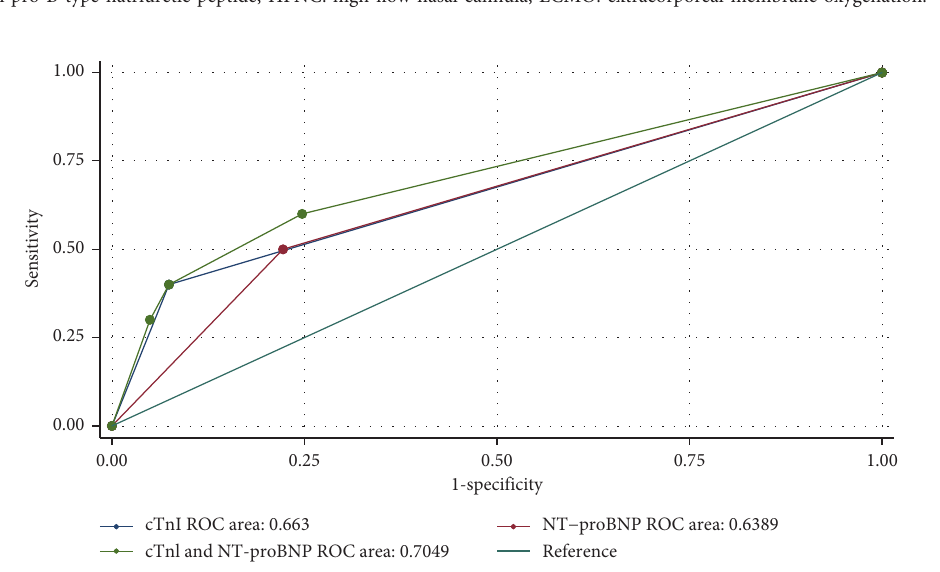
Figure 3: The receiving operating characteristic analysis comparing the predictive value of cTnI, NT-proBNP, or the combination of these two biomarkers for the composite events. NT-proBNP: N-terminal pro-B-type natriuretic peptide; hs-cTnI: high-sensitivity cardiac troponin